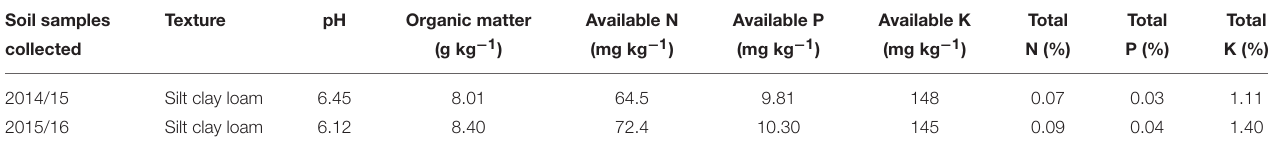
TABLE 1 | Physico-chemical properties of the soil before the study conducted in 2014/15 and 2015/16. Soil samples Texture pH Organic matter Available N Available P Available K collected